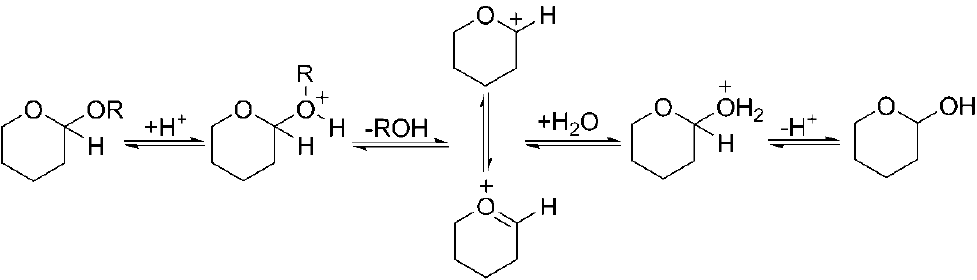
Figure 4. Hydrolysis mechanism of steroidal alkaloids, where R represents glycosyl.